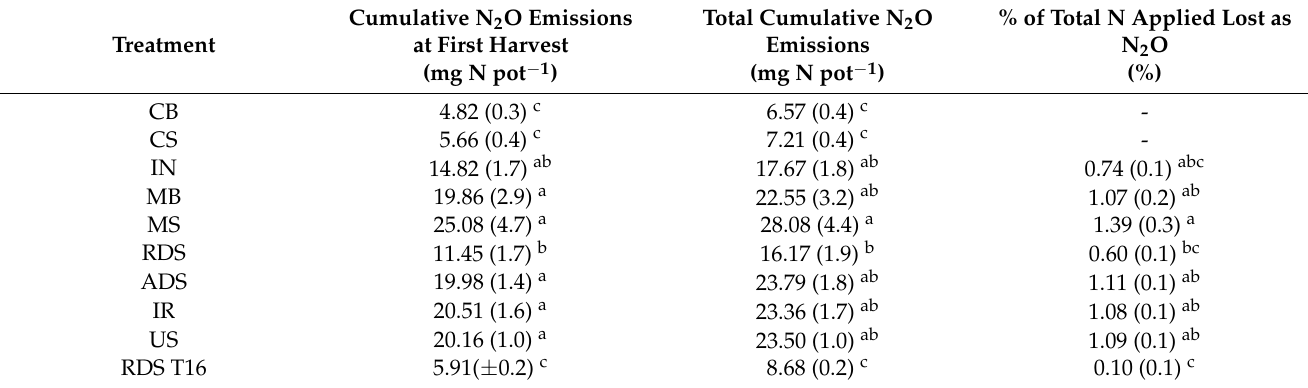
Table 2. Cumulative N 2 O–N emissions before the first harvest (effect of basal fertilization), total cumulative emissions (effect of basal + two topdressing fertilization) and percentage of total ni- trogen applied (basal + two topdressing fertilization) lost through N 2 O–N emissions (excluding control emissions). Values followed by different letters in the same column are significantly different ( p < 0.05) based on the Tukey test. (mean, n = 3).